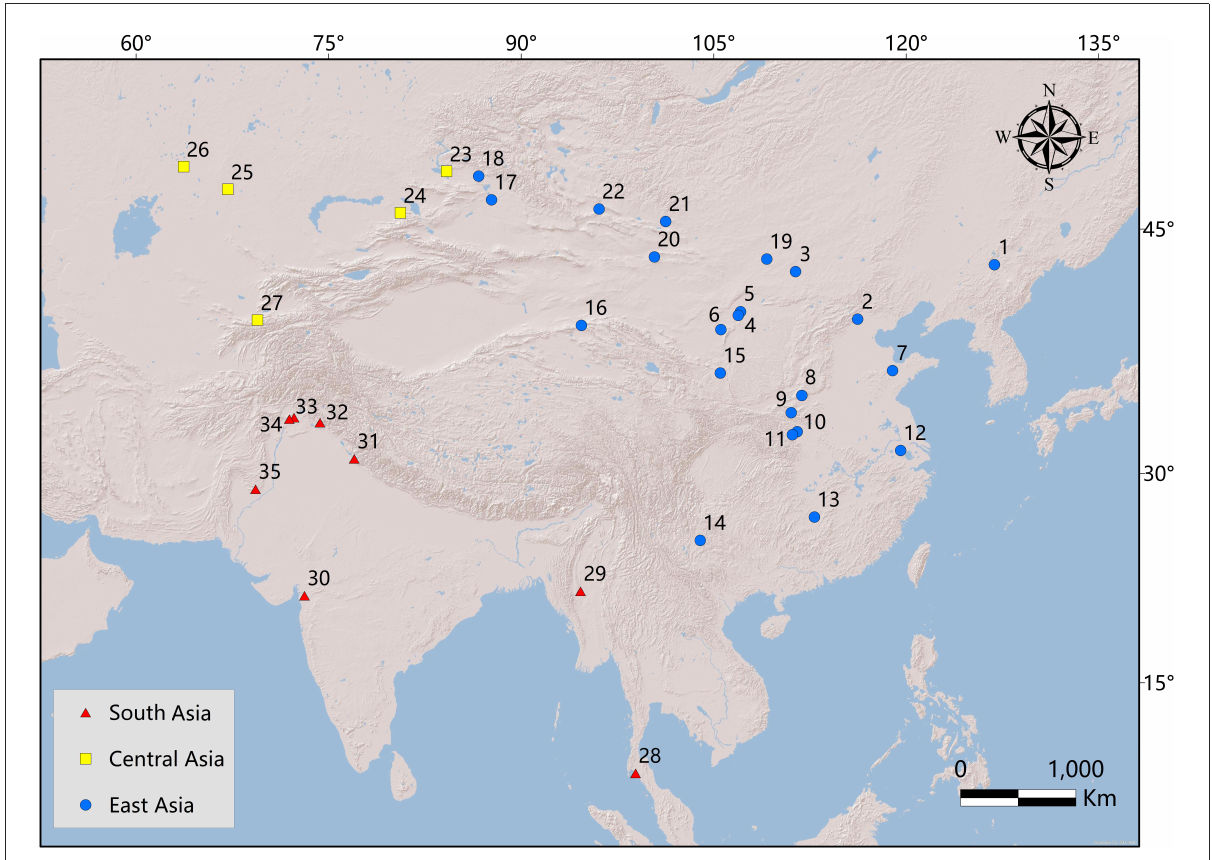
FIGURE1 Principal Paleogene rodent localities of Asia are drawn in ArcMap10.3. Blue circles represent localities of East Asia, yellow squares represent localities of Central Asia, and red triangles represent localities of South Asia. Localities 1-17 are from China: 1. Huadian; 2. Changxindian; 3. Erlian Basin; 4. Qianlishan; 5. Saint Jacques; 6. Ulantatal; 7. Wutu; 8. Yuanqu; 9. Lushi; 10. Liguanqiao; 11. Danjiangkou; 12. Shanghuang; 13. Lingcha; 14. Caijiachong; 15. Haiyuan; 16. Danghe; 17 Ulungur River area; and 18. Burqin. Localities 19-22 are from Mongolia: 19. eastern Gobi Desert; 20. Nemegt Basin; 21. Valley of Lakes; and 22. Shine Us. Localities 23-26 are from Kazakhstan: 23. Zaysan; 24. Shinzhaly; 25. Kyzyl-Kak; and 26. Chelkar-Teniz; 27. Andarak 2 (Kyrgyzstan); 28. Krabi (Thailand); and 29. Pondaung (Myanmar). Localities 30–32 are from India: